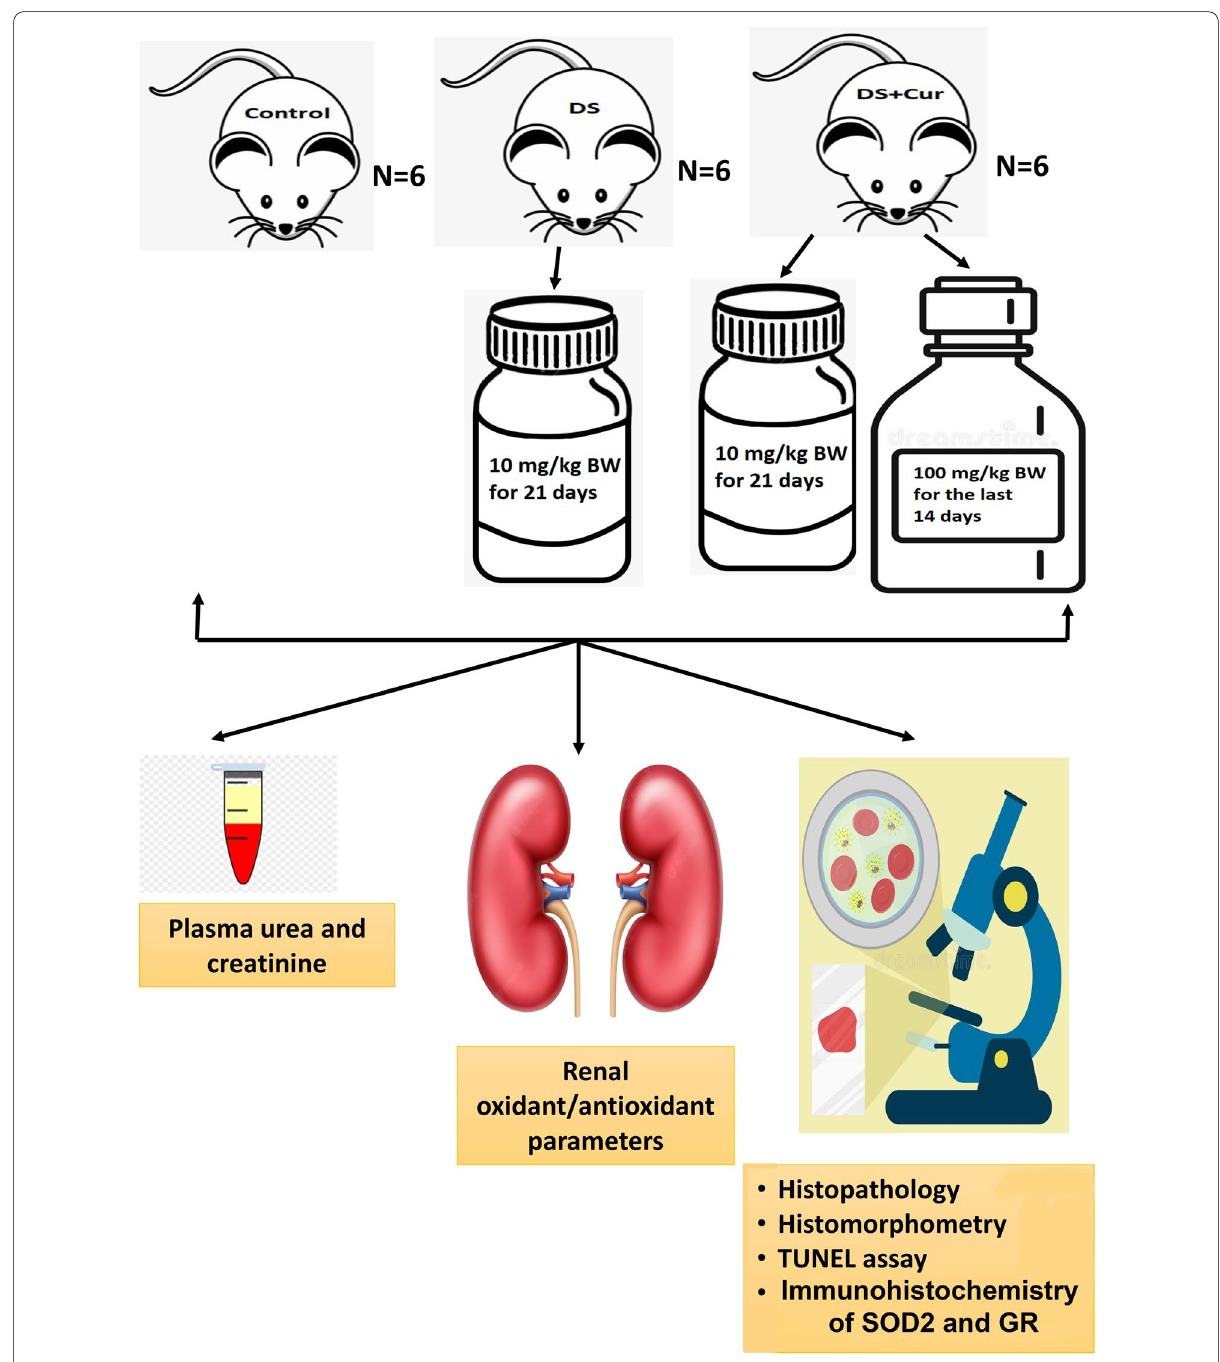
Fig. 1 Chart clarifies the experimental